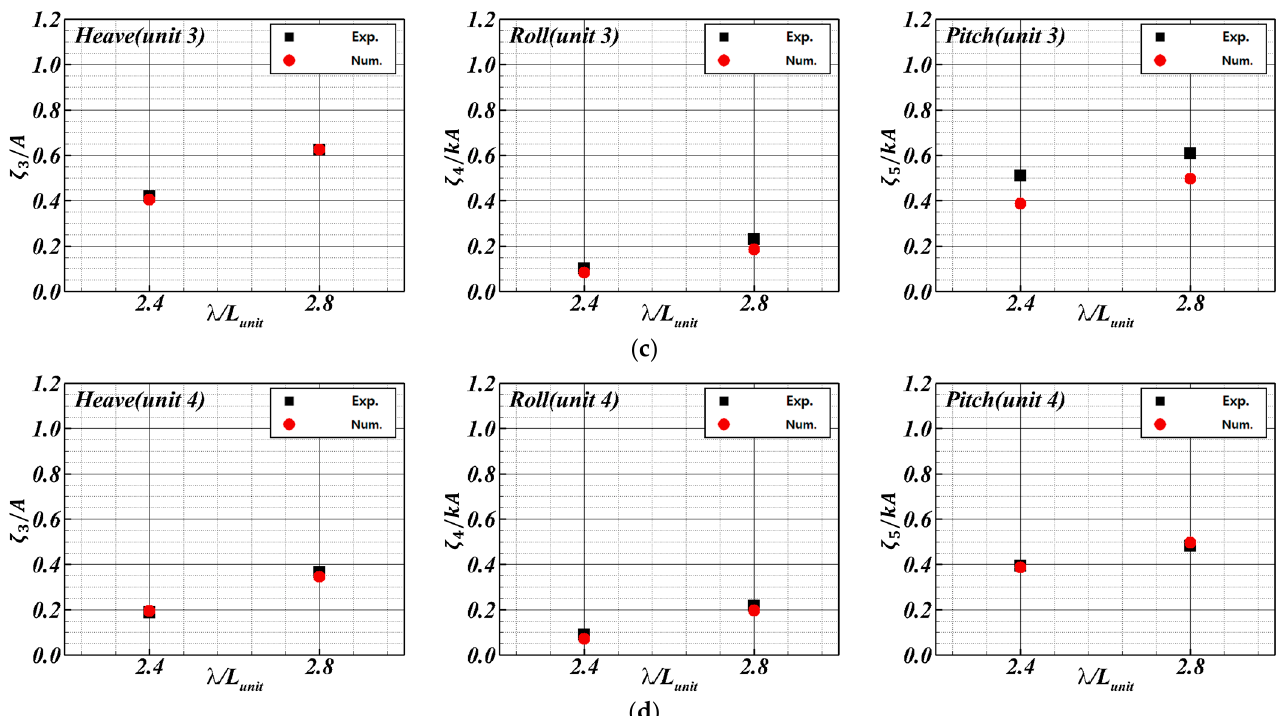
Figure 27. Motion RAOs of heave ( left ), roll ( center ) and pitch ( right ) under oblique sea: ( a ) Unit 1; ( b ) Unit 2; ( c ) Unit 3; ( d ) Unit 4.